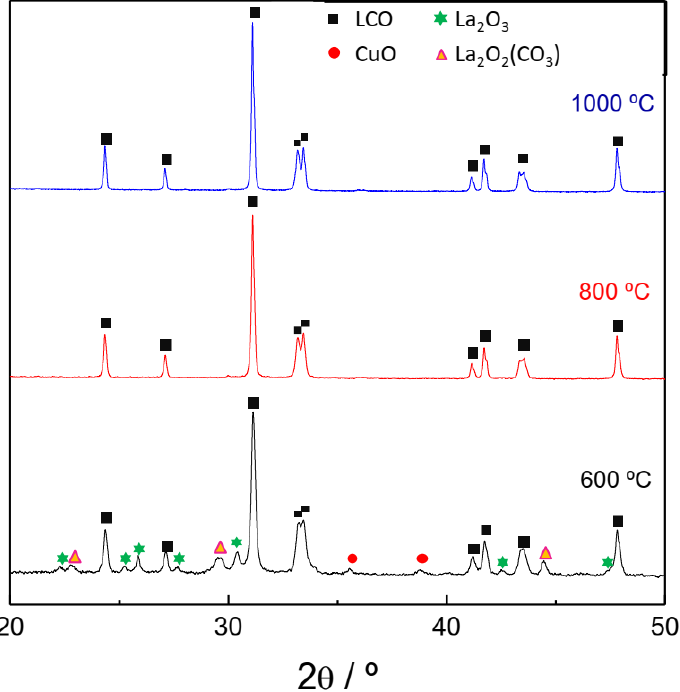
Figure 1. XRPD patterns of La 2 CuO 4 − δ sintered at 600, 800 and 1000 ◦ C for 1 h. Figure 2 displays the XRPD patterns of the La 2 CuO 4 − 0.5x A x (A = F, Cl, Br; x = 0.1–0.3) series sintered at 1000 and 1100 ◦ C for 1 h. All compounds crystallize with orthorhombic symmetry. In the F-doped series, it is observed that F 0.1 is in a single phase at 1000 ◦ C (Figure 2a). However, extra diffraction peaks assigned to LaOF (PDF number: 00-006-0281) are observed when the fluorine content increases above x = 0.1. In this case, it is necessary to increase the temperature to 1100 ◦ C to completely incorporate the F − into the La 2 CuO 4 − δ structure. LaOF is also detected for the F 0.3 sample sintered at 1100 ◦ C, suggesting that the solubility limit of F − in La 2 CuO 4 − δ , under the experimental conditions used in this work, is close to x = 0.2.